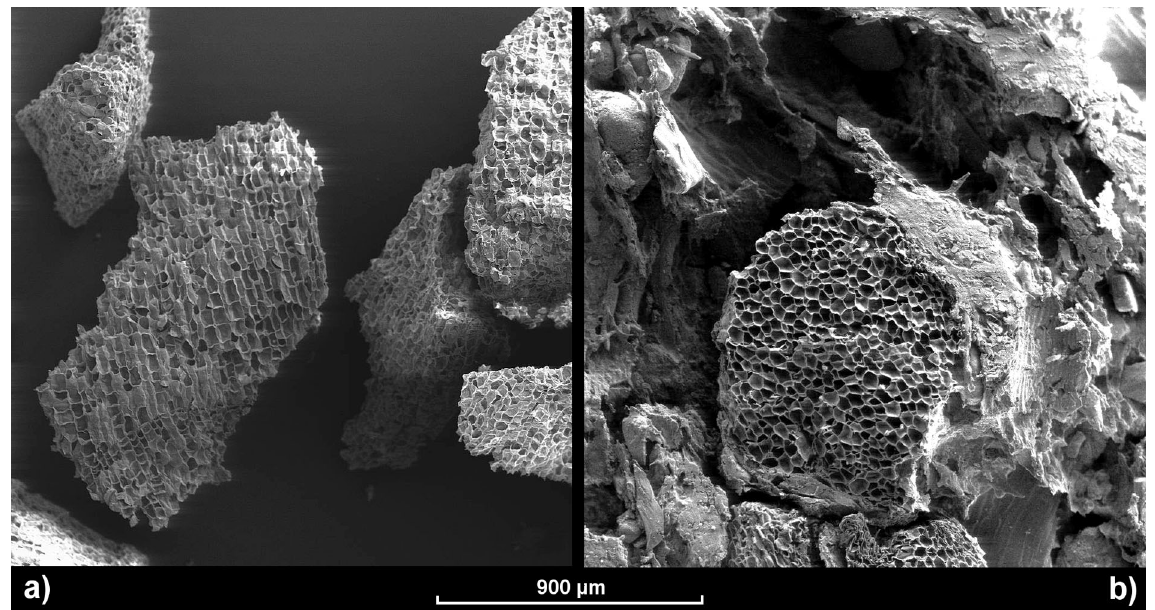
Fig. 3. Scanning electron microscope images of (a) an individual cork Quercus suber particle, ∅ 0.5−1 mm (Amorim) and (b) cork granules embedded in a feed pellet after